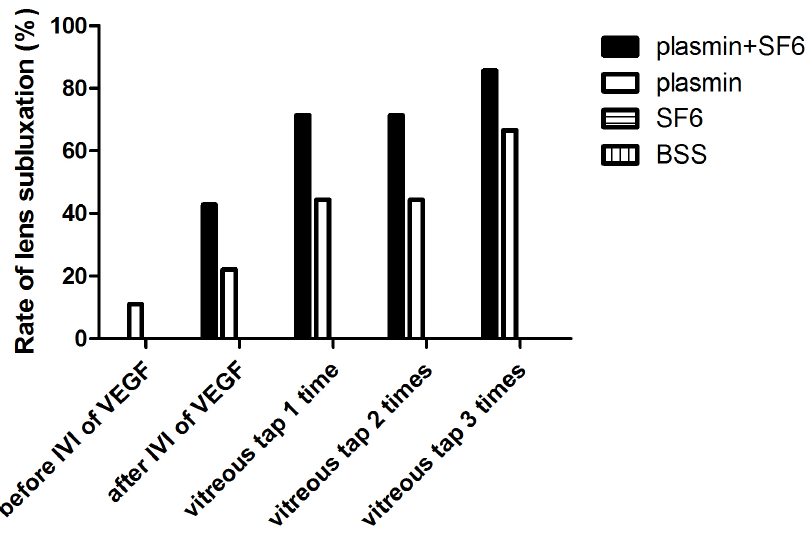
Figure 3. Rate of lens subluxation. Rate of lens subluxation after intravitreal injections of plasmin and/or SF 6 and subsequent elevation of vascular endothelial growth factor (VEGF) levels, and vitreous tap was performed 3 times is shown. Lens subluxation was noted in the eyes treated with plasmin before the injection of VEGF. After intravitreal injections of VEGF, and vitreous tap was performed 3 times, lens subluxation increased in the eyes treated with plasmin and SF 6 (plasmin + SF 6 group) or plasmin alone (plasmin group). The eyes treated with SF 6 (SF 6 group) or BSS (BSS group) showed no signs of lens subluxation.